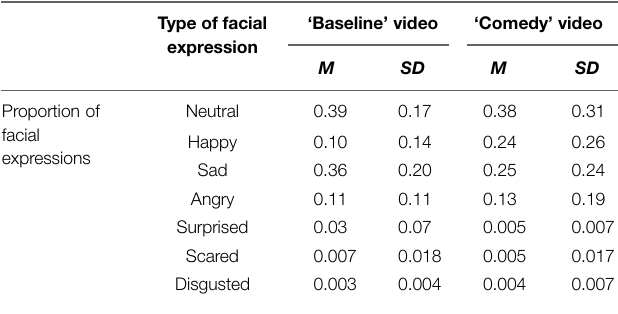
TABLE 2 | Proportion of facial expressions for baseline and comedy video.